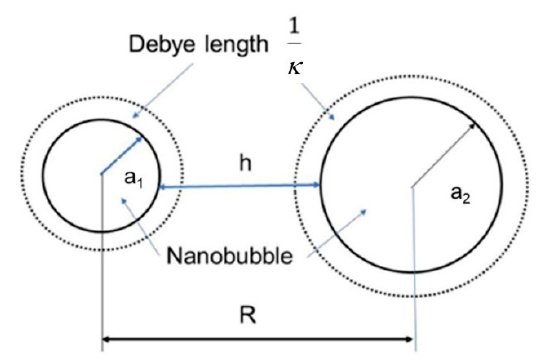
Figure 7. Position and geometry of two